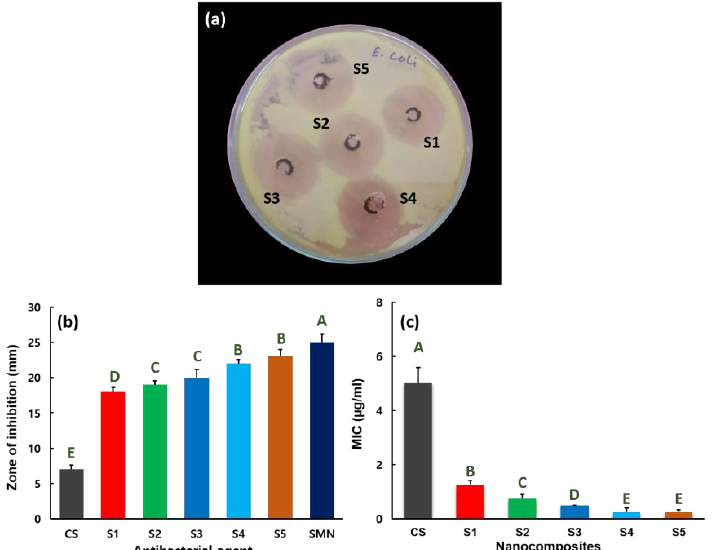
Figure 5. ( a ) Antibacterial activity of nanocomposites S1–S5 versus E. coli organism. ( b ) Zone of inhibition for CS, SMN, and nanocomposites S1–S5, stated as mean ± SD from the results of triplicate tests. Statistical analysis indicated that the values are significantly ( p ≤ 0.05) varied between their experiments which are indicated by capital letters. ( c ) MIC values for CS and nanocomposites S1–S5 versus E. coli , expressed as mean ± SD from the triplicate tests. Statistical analysis indicated that the values are significantly ( p ≤ 0.05) varied between their experiments, which are indicated by capital letters.